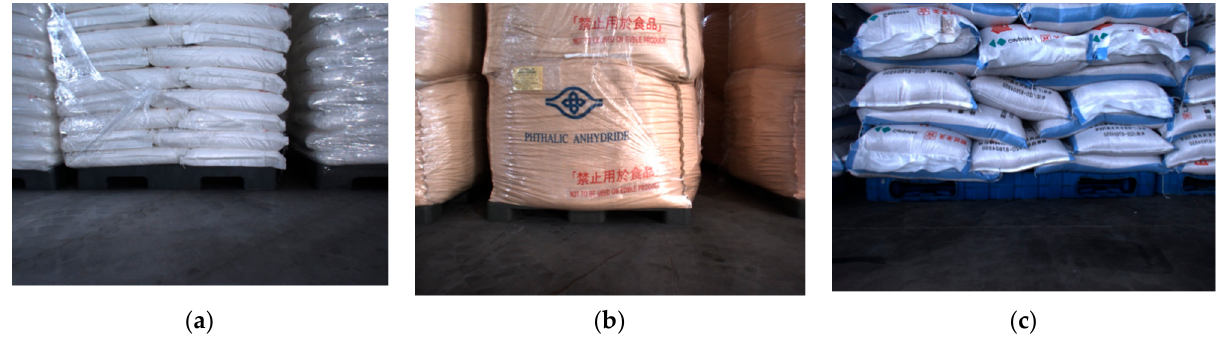
Figure 3. Pallet examples in warehouse. (a) Example a. (b) Example b. (c) Example